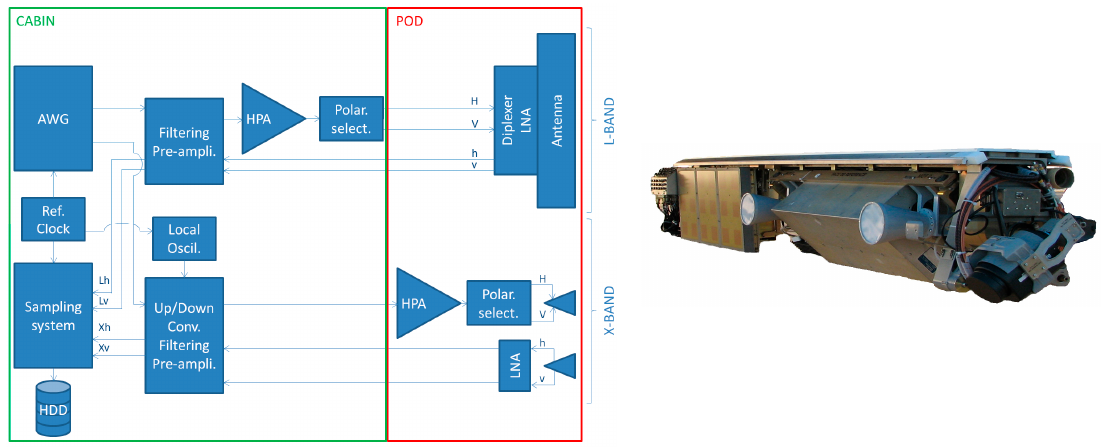
Figure 5. SETHI quad-polarization X+L configuration: Synoptic of sensors and view of in-pod L-band patch array and X-band horn antennas (with optical camera in the foreground).